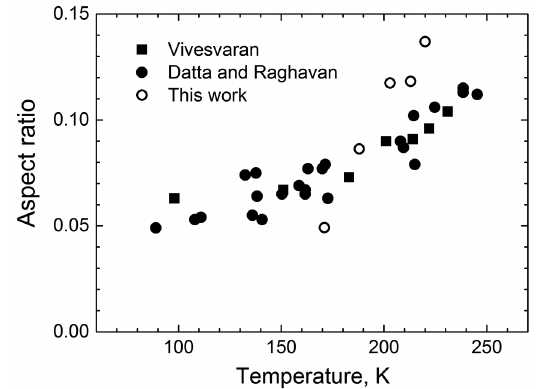
Figure 2. Comparison of the values of the martensite aspect ratio, mean half-thickness to radius of martensite units, in different alloys obtained from Datta & Raghavan 32 and Visvesvaran 33 .